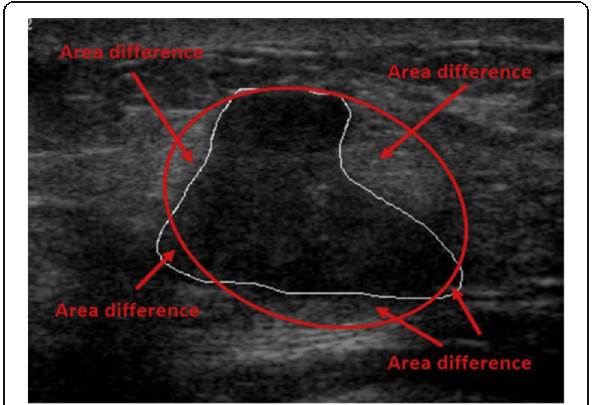
Fig. 1 Area difference between a breast malignant mass and its equivalent ellipse Fig. 2 Original contour (white), inside contour (red), and outline